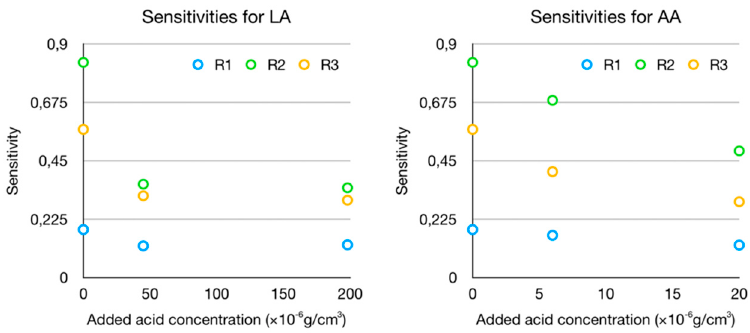
Figure 8. Sensitivities of the sensors to the added acids concentrations.